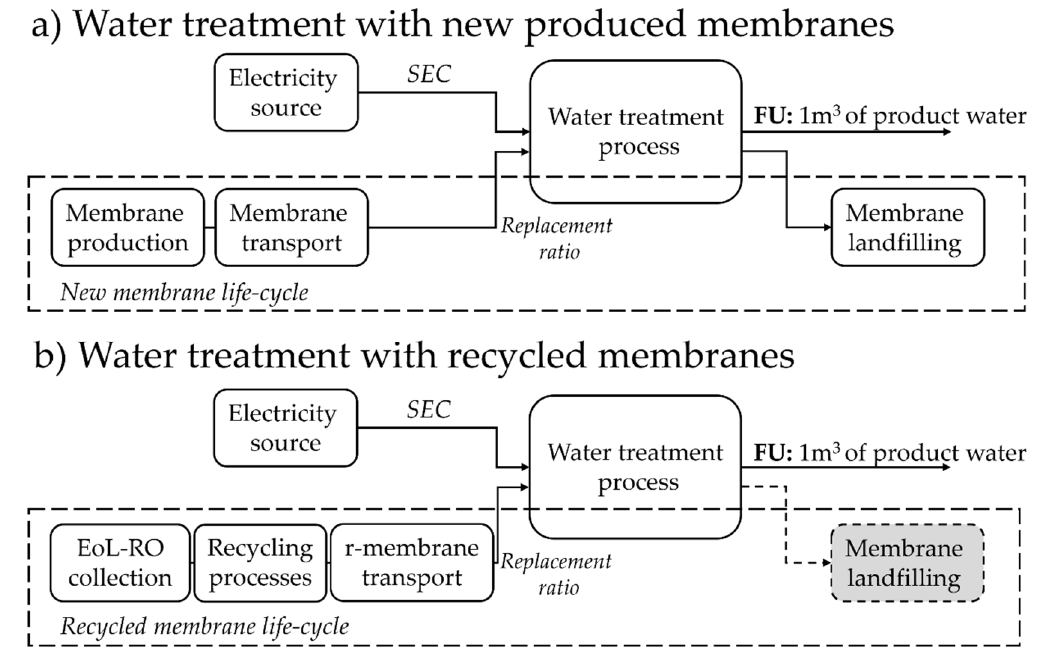
Figure 1. System boundaries and main foreground processes: ( a ) NF process with commercial NF membranes, and ( b ) NF process with r-NF membranes Grey boxes contain compensated impacts due to recycling.